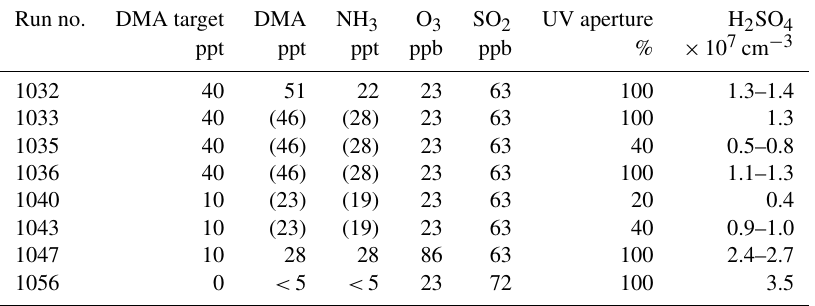
Table 1. Overview of experimental conditions for the TDCIMS measurements described. The chamber temperature was 278K and the relative humidity was 38%. DMA and NH 3 measurements are given (parts per trillion by volume) when coincident with the TDCIMS observations, and otherwise averages for the same experimental conditions close in time are given as estimates, indicated with parentheses. O 3 and SO 2 are reported in parts per billion by volume. Larger UV aperture fractions allow more ultraviolet light into the chamber, resulting in greater rates of SO 2 oxidation to H 2 SO 4 . Run no. DMA target